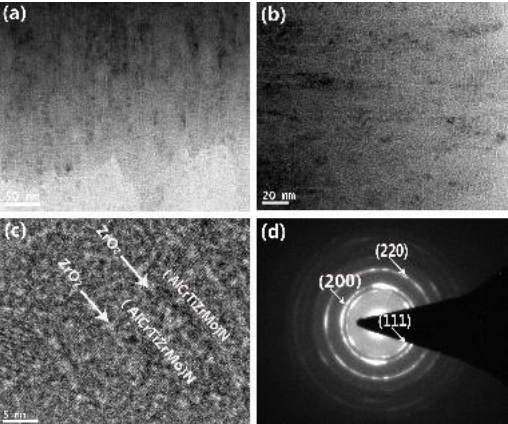
Figure 3. Cross-sectional HRTEM images of the (AlCrTiZrMo)N/ZrO 2 nano-multilayered film with the ZrO 2 layer thickness of 0.6 nm: (a) low magnification, (b) medium magnification, (c) high magnification, and (d) selected electron diffraction patter n.